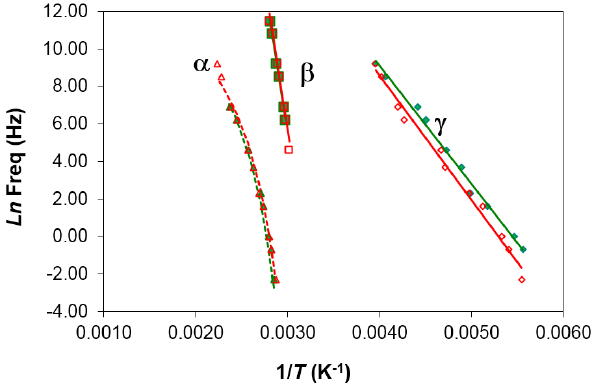
Figure 15. Relaxation map for PEI800-PLA5 at different heating rates: 2 °C/min (filled symbols) and 0.5 °C/min (open symbols).